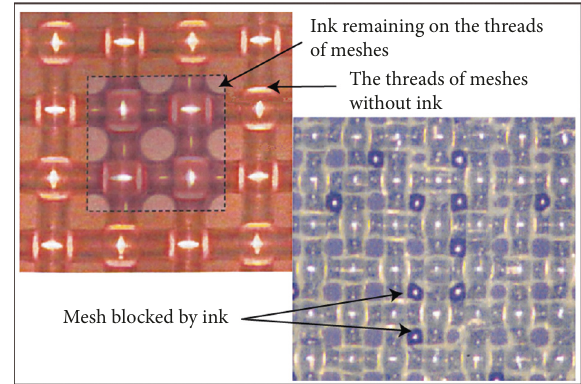
Figure 2: Screen printing blocked by conductive ink.